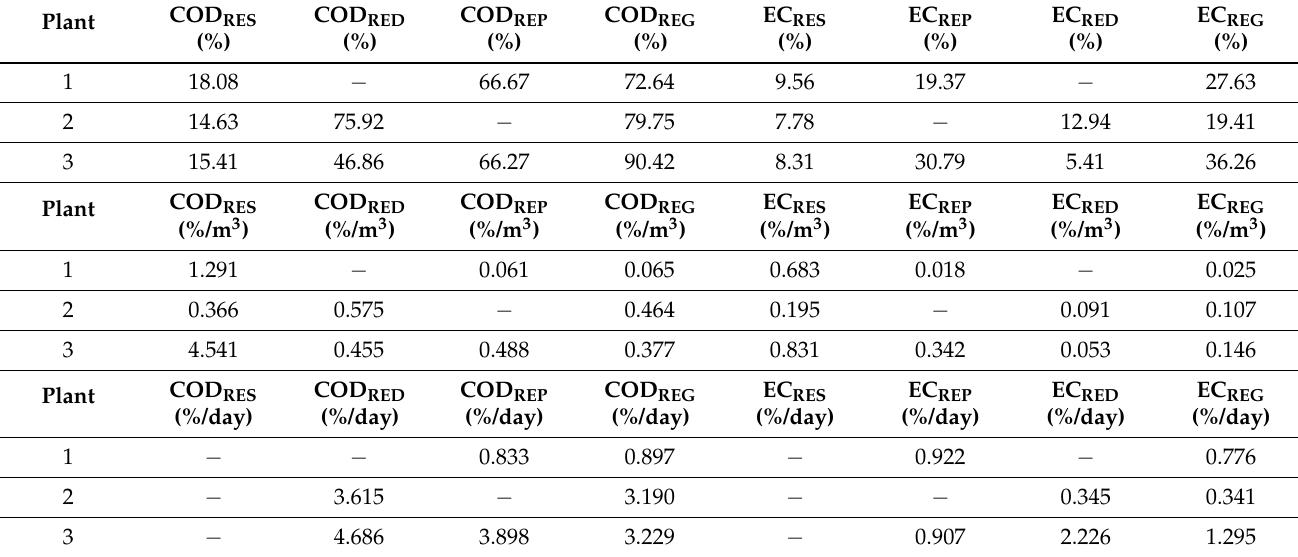
Table 3. Removal rate values (COD, EC...).